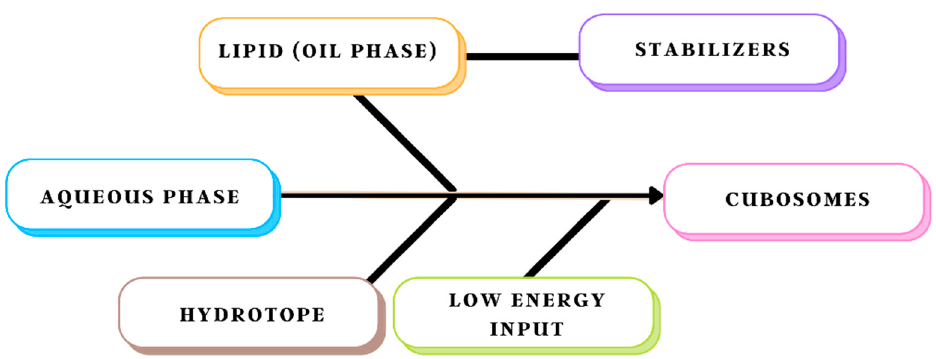
Figure 4. Schematic representation of the bottom-up approach